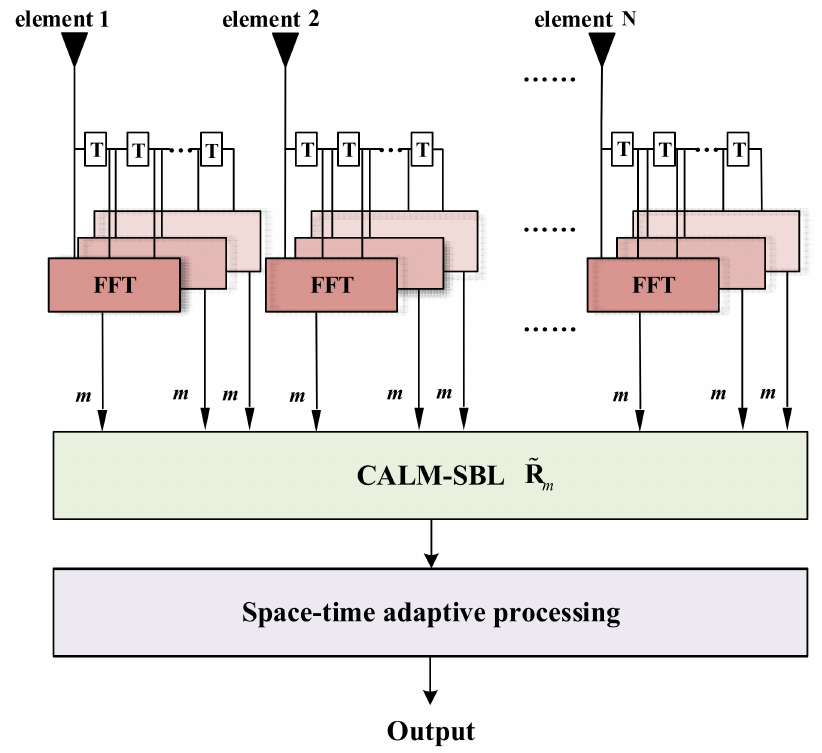
Figure 5. Block diagram for